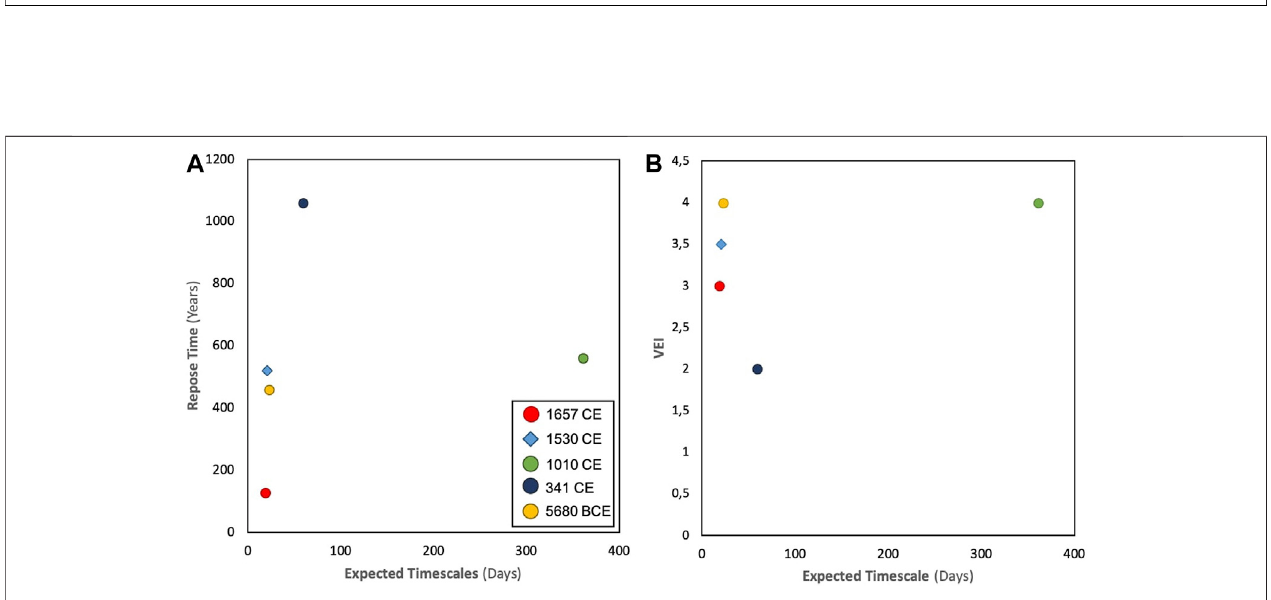
FIGURE10| Expectedtimescalevariationdiagramsfor (A) ReposeTime, (B) VolcanicExplosiveIndex(VEI).Reposetimeforthe5680Cal.BCEeruptionisbaseda collapse event at 7160 Cal. BCE, the closest datable event. *1530 Cal. CE eruption data from Boudon et al. (2008); Bourgeoisat (2018); Pichavant et al. (2018).